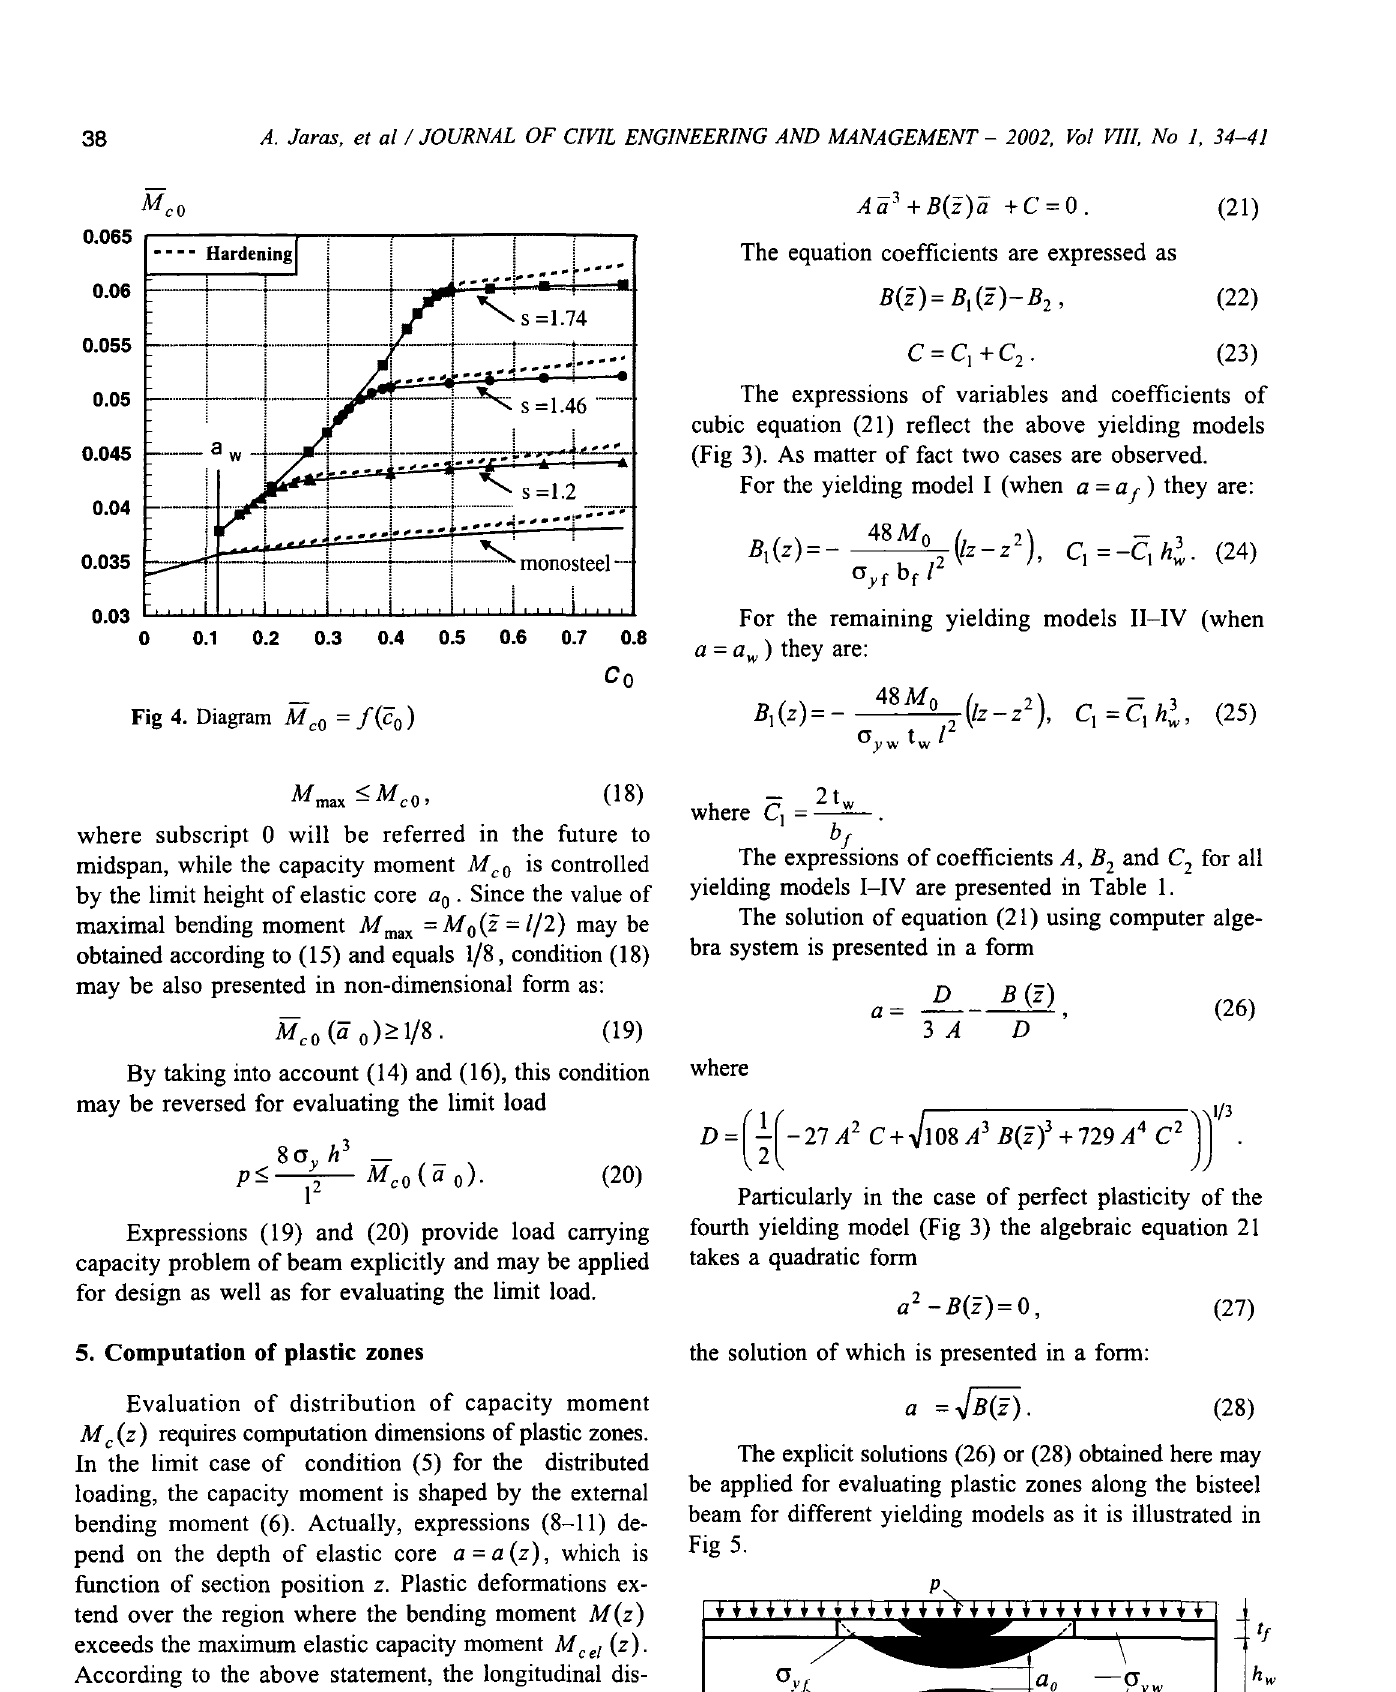
Fig 3. After submission of bending moment (14-15) and capacity moment (8) and (17) the non-dimensional height of elastic core a= a(z) can be found by solving cubic algebraic equation